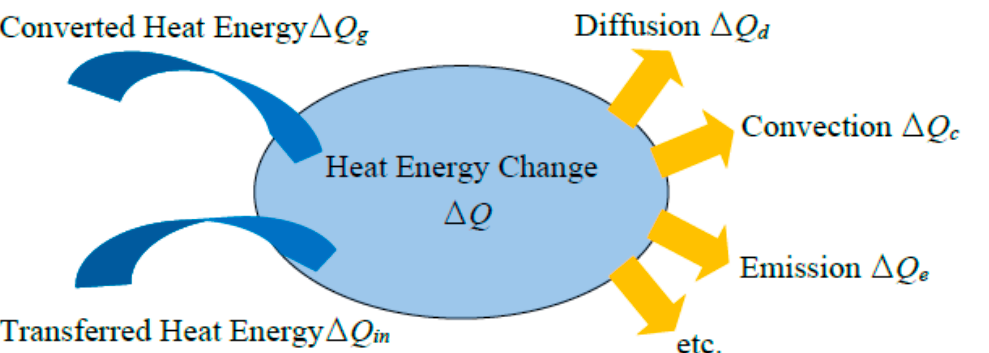
Figure 1. Sketched view of a heat balance system.